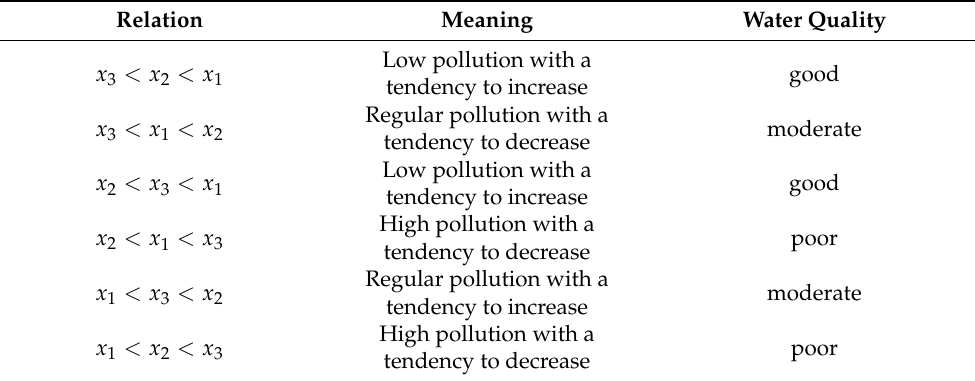
Table 2. Relationships between the cardinalities of different AM classes, meaning, and classification of water quality. Relation Meaning Water Quality